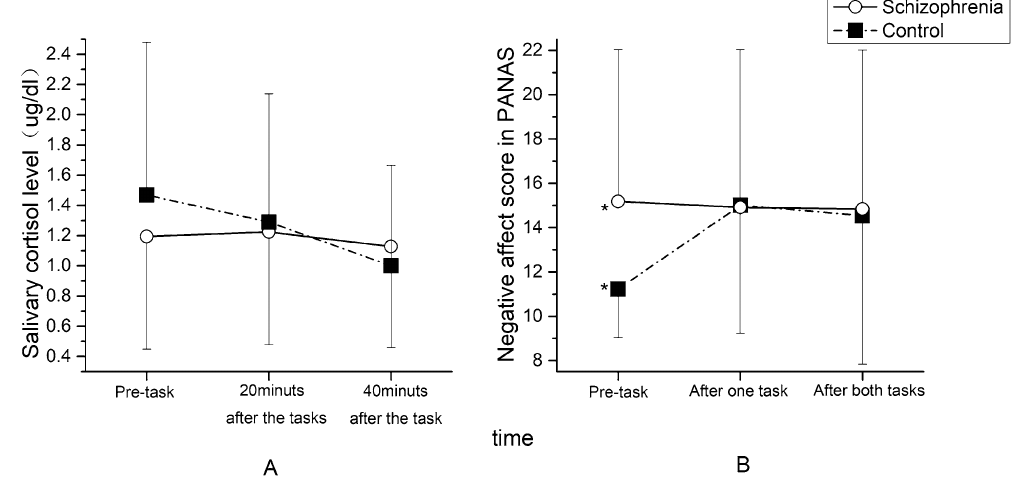
Figure 2. Salivary cortisol levels (A) and NA scores (B) of patients and controls (* p <